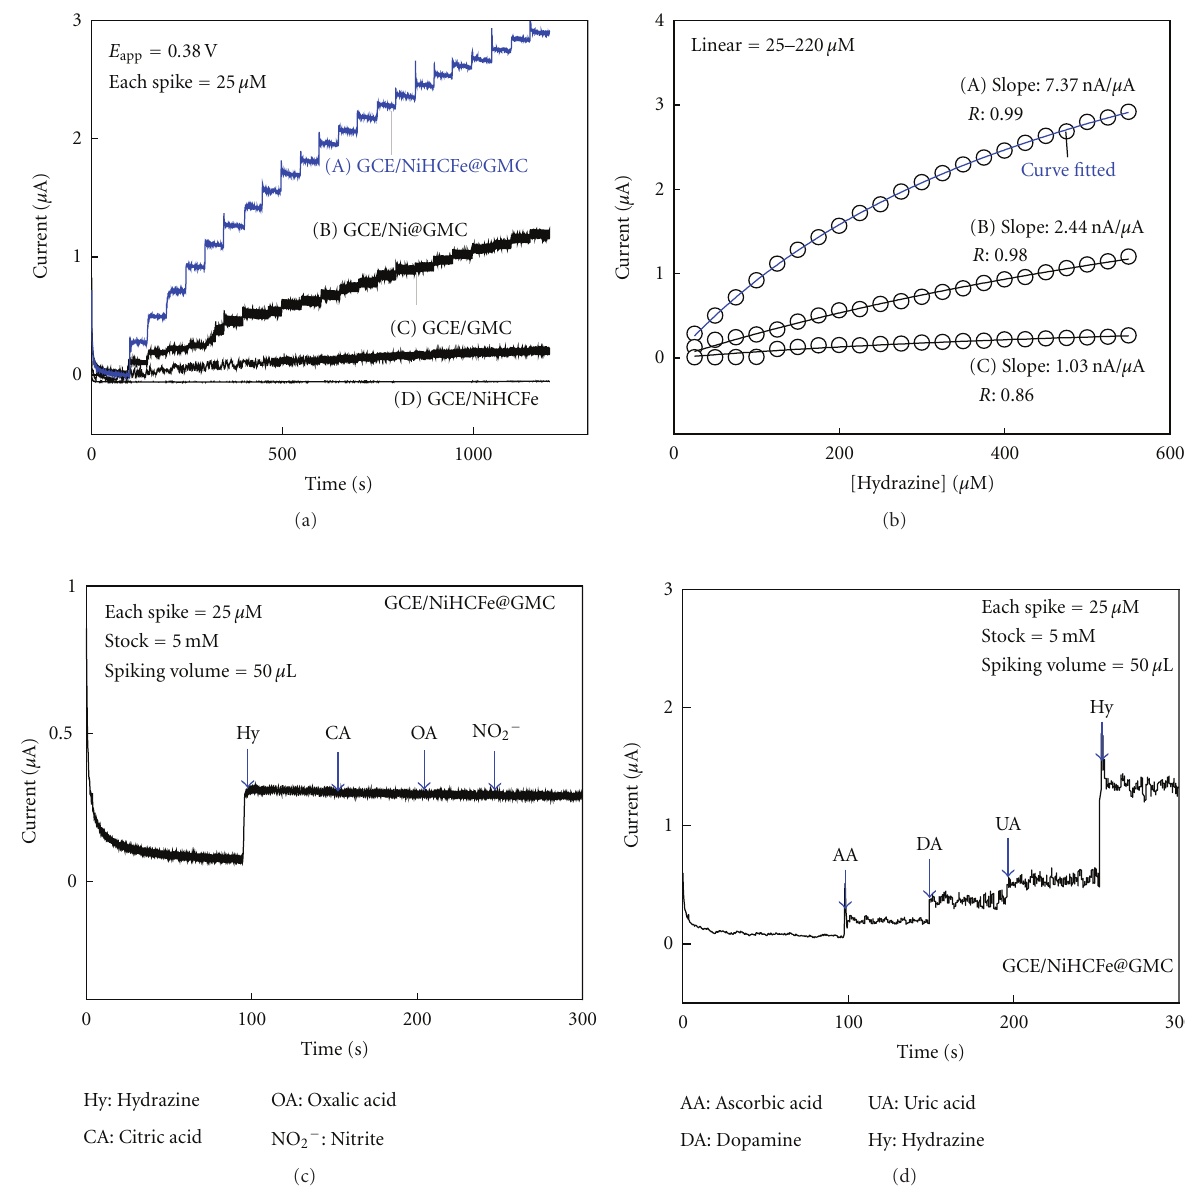
Figure 6: (a) Typical amperometric i-t responses of various chemically modified electrodes for the detection of hydrazine at an applied potential of 0.38 V versus Ag/AgCl in a pH 7PBS and (b) its corresponding plots of current versus hydrazine concentration. (c) and (d) E ff ect of interferents on GCE/NiHCFe@GMC at an applied potential of 0.38